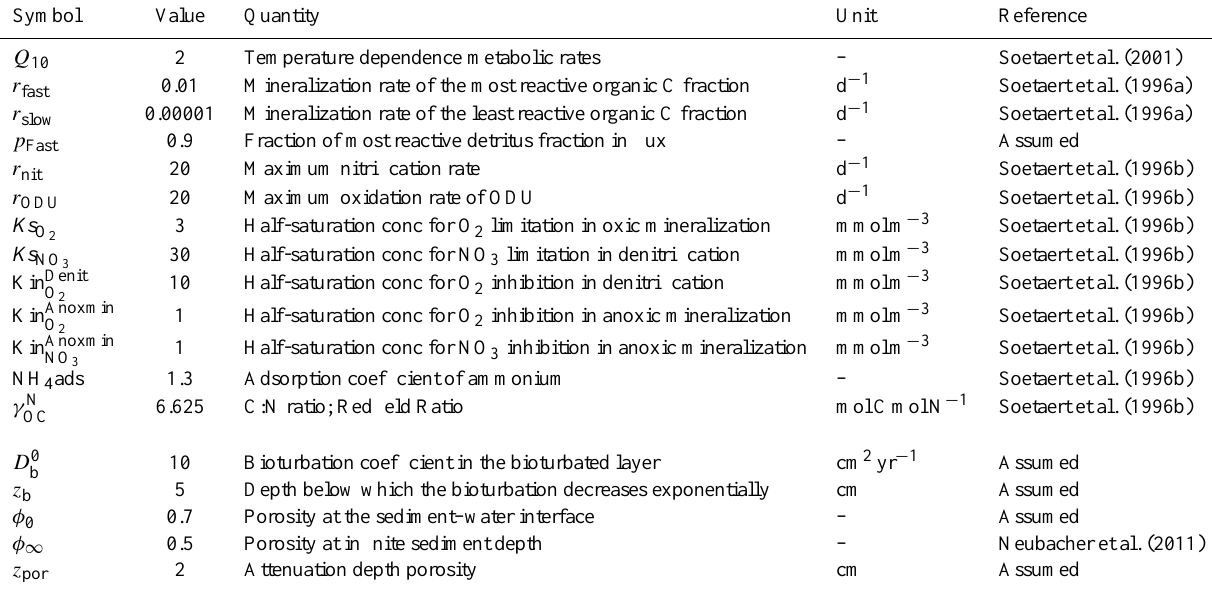
Table 9. Parameter values of the benthic ecosystem model. All rate parameters are defined at 0 ◦ C.